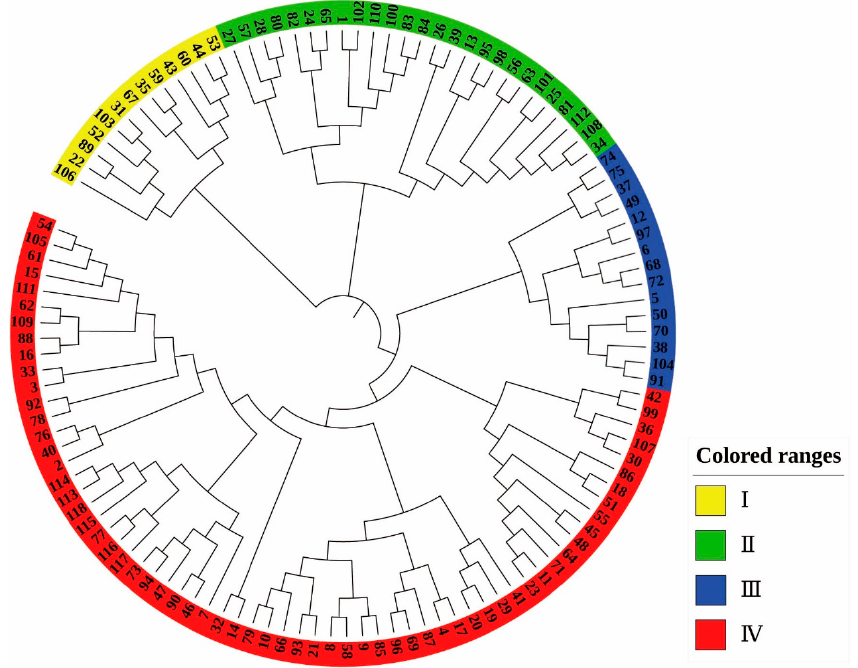
Figure 5. NJ clustering analysis of 118 Castanea plant materials. The labels in the figure represent the material number (corresponding to Table S4).